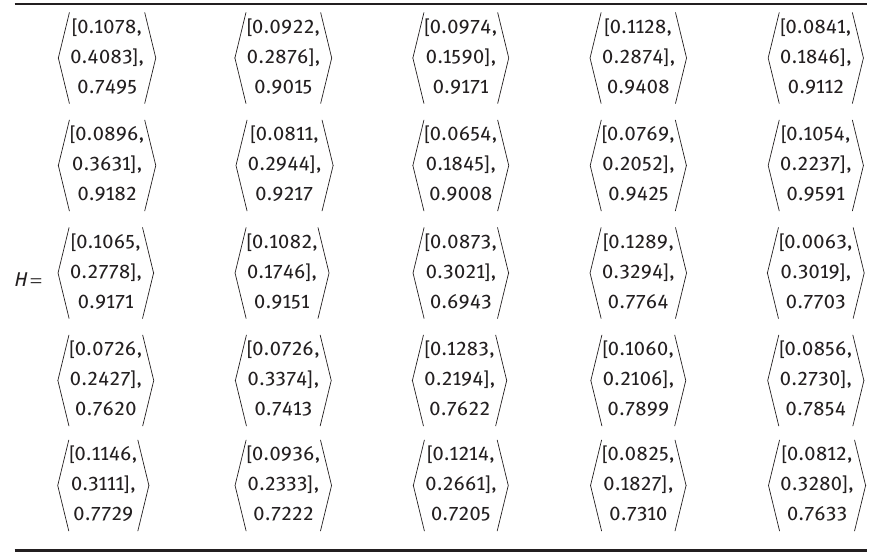
Table 11: The Weighted Aggregated Cubic Fuzzy Set Decision Matrix.